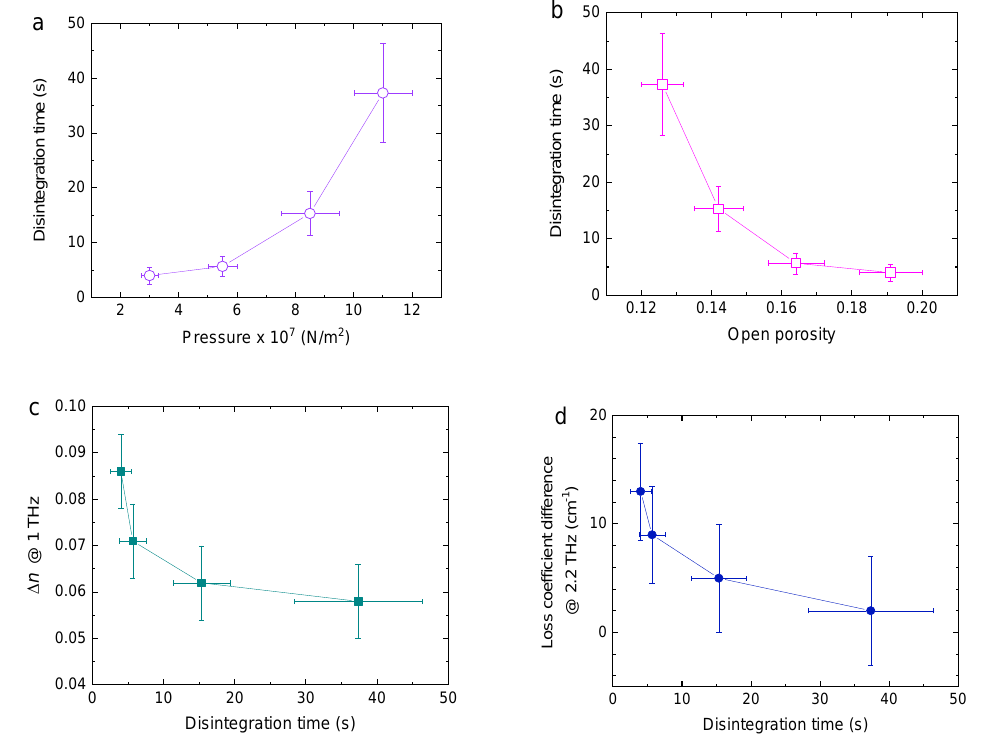
Figure 7. ( a ) Disintegration time of pellets as a function of pressure. ( b ) Disintegration time as a function of open porosity. ( c ) Refractive index difference between dry and paraffin-soaked pellets @ 1 THz as a function of DT. ( d ) Loss coefficient difference between dry and paraffin-soaked pellets @ 2.2 THz as a function of DT. The errors in the refractive index and loss are the standard deviation of four pellet samples.